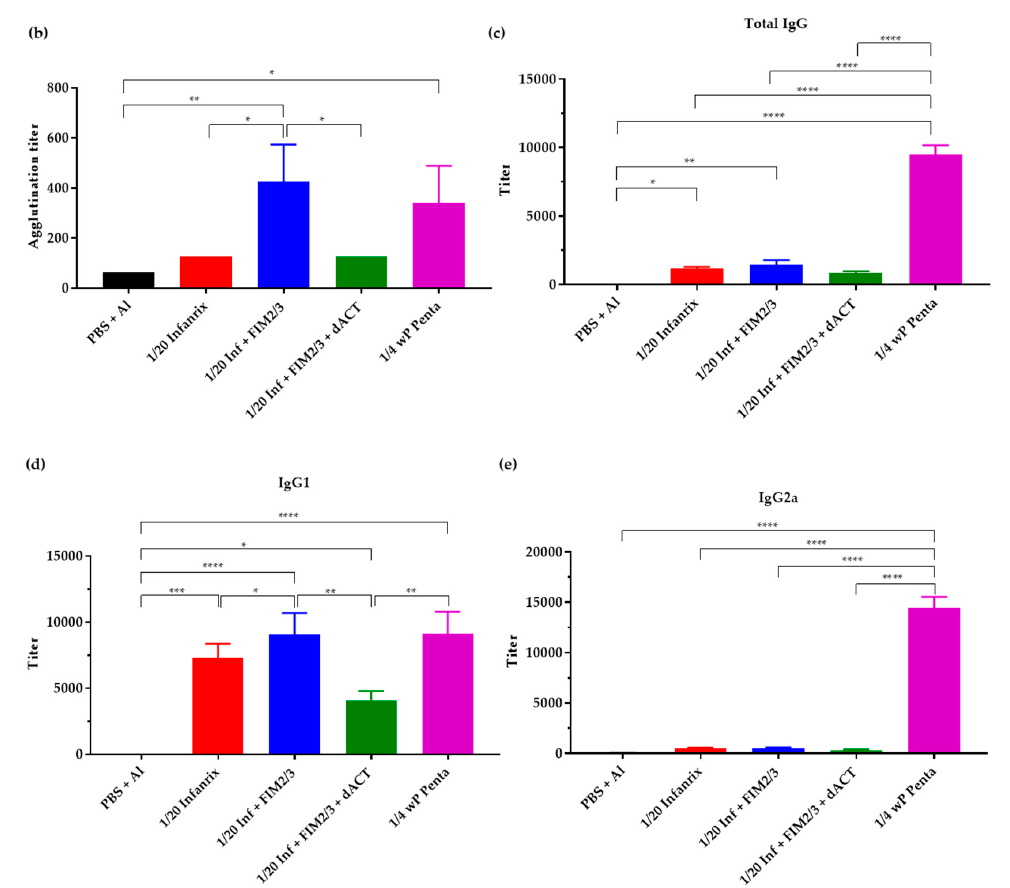
Figure 4. Innate and adaptive immune response elicited in BALB / c mice immunized by 1 / 20 HD of antigen-supplemented Infanrix ® aP vaccine. ( a ) Sera from mice immunized as described in the legend of Figure 3 were obtained on day 35 and heat-treated for complement inactivation (empty bars) or not (full bars) before use for opsonization of mScarlet-expressing B. pertussis bacteria. Opsonophagocytic uptake into di ff erentiated HL-60 cells was performed as described in the Materials and Methods and analyzed by flow cytometry. A representative experiment performed in triplicate is shown. The fold change of mean fluorescence intensity (MFI) was calculated by dividing the MFI obtained in the presence of immune plasma by the MFI obtained upon incubating cells with bacteria in the presence of plasma from PBS + alum vaccinated mice. Data are shown as mean ± SD. Tukey´s multiple comparison test was used to analyze the statistical significance between groups. Only significant di ff erences are indicated. * ( p < 0.05); **** ( p < 0.0001). ( b ) Agglutination titers of the sera were determined as the last dilution that agglutinated the standardized B. pertussis cell reagent (TestLine Clinical Diagnostics). n = 3 biological replicates performed in triplicates. Data shown as mean ± SD. Tukey´s multiple comparison test was used to analyze the statistical significance between groups. Only significant di ff erences are indicated. * ( p < 0.05); ** ( p < 0.01). ( c – e ) Antibody responses to B. pertussis elicited by the various vaccine